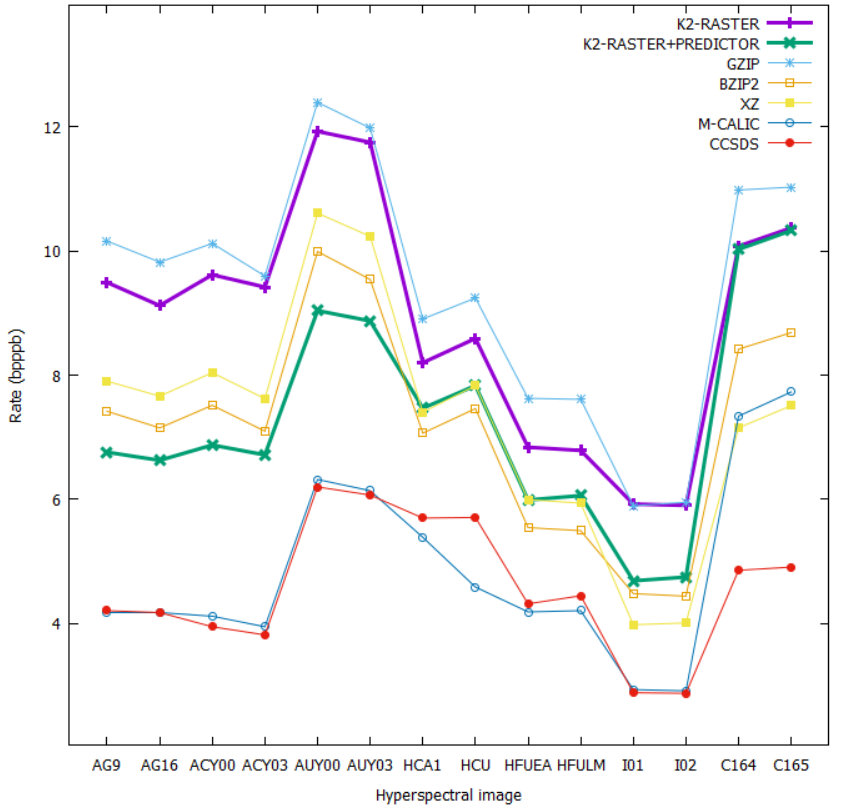
Figure 12. A rate (bpppb) comparison with other compression